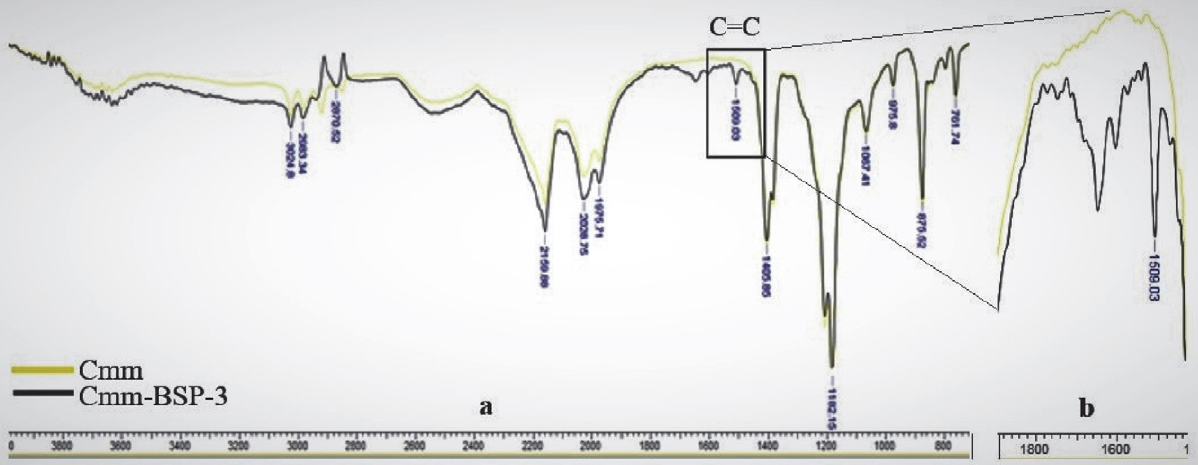
Figure 4 a. FTIR Image after BSP-3 addition b. Zoomed FTIR image of C = C band showing